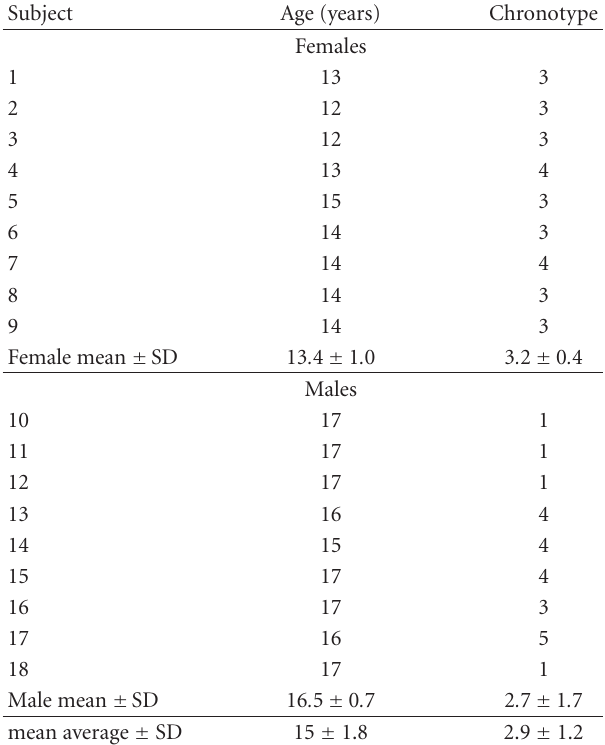
Table 1: Chronotypes of each